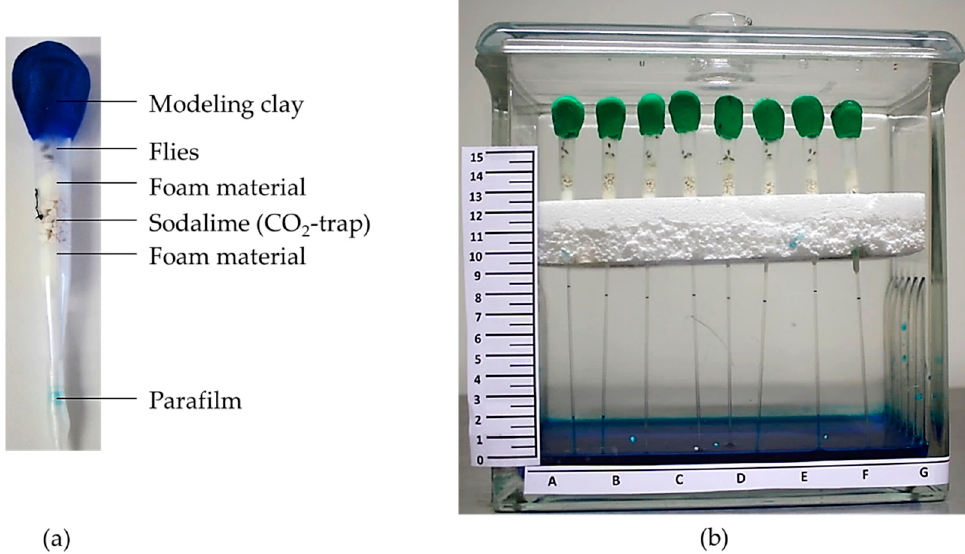
Figure 3. Schematic of the self-assembled respirometer setup. ( a ) The respirometer is a small metabolic chamber built from a pipette tip, a micropipette, Parafilm, foam and CO 2 -absorbing soda lime. After brief anesthetization, flies are placed into the respirometer chamber, which is subsequently closed with a plug of food and covered with plasticine. ( b ) After an adaptation period, the respirometers are inserted into a holder in an outer chamber so that the micropipette tips are immersed into a layer of dyed water. The lid of the outer chamber is closed, and a first photograph is taken. The changes in the filling volume of the micropipettes are documented with additional photographs. By using image processing software, the distances of capillary filling are determined. The amount of CO 2 produced per fly and hour is calculated via the formula: (micropipette radius × ratio of capillary filling of the micropipette at the start and end point for the sample—negative control) × 1000)/(number of flies × duration of exposure) (modified from [43]).